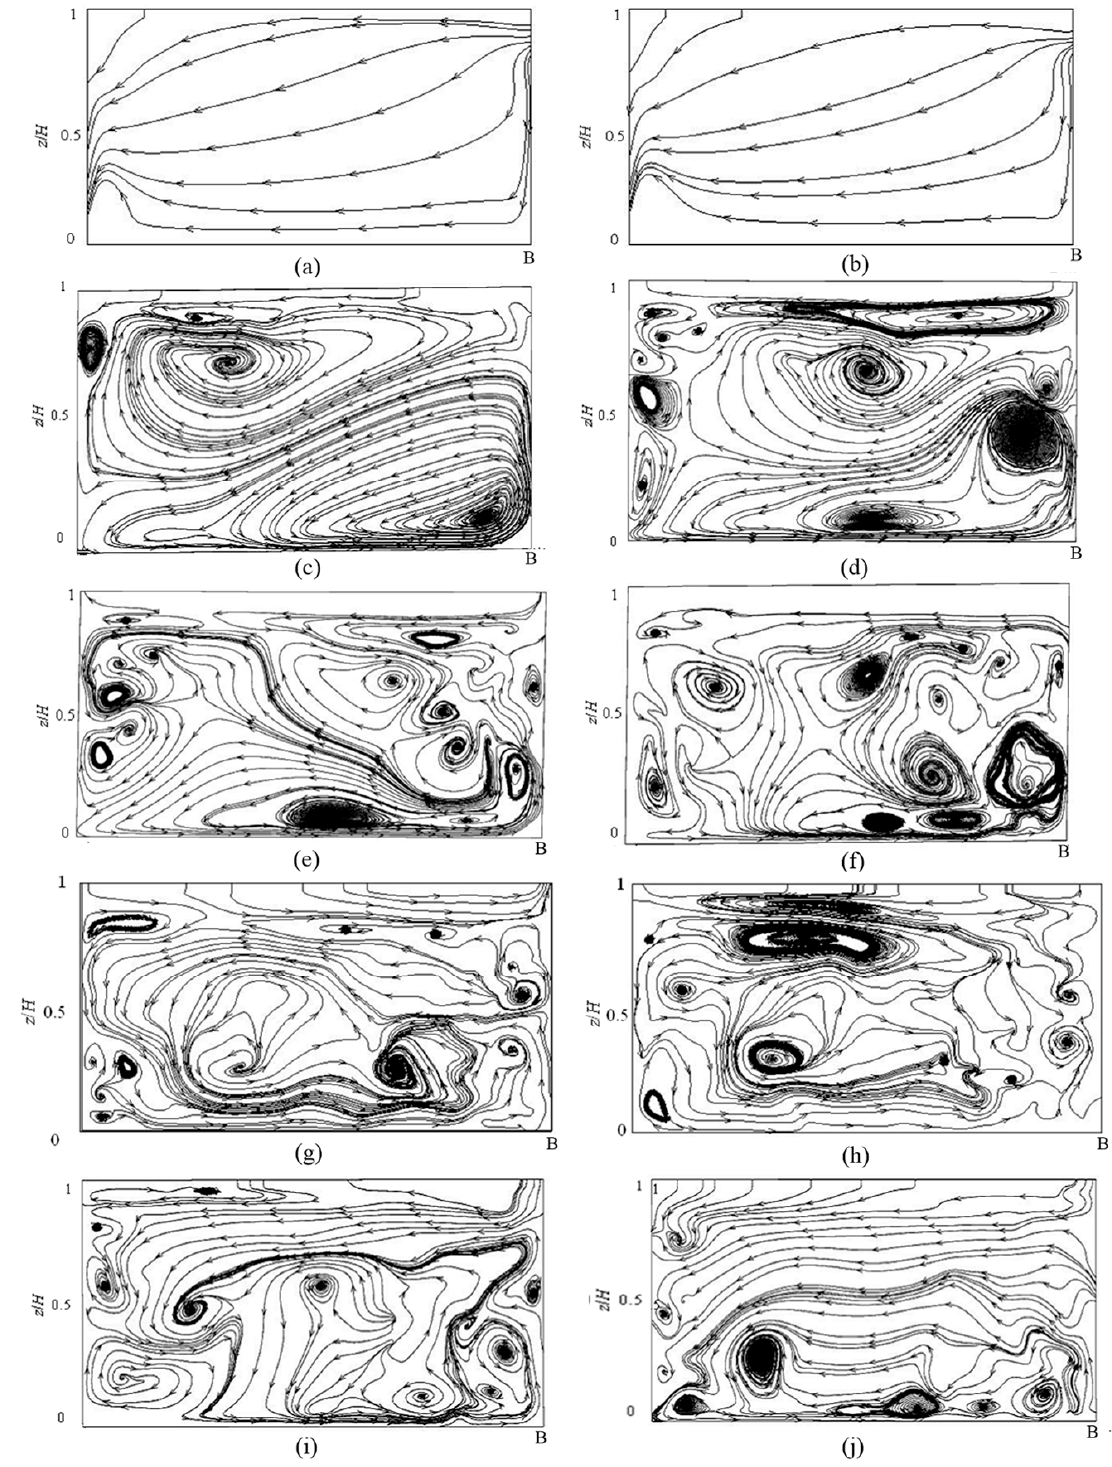
Figure 12. Flow chart of sections: ( a ) Q0.5; ( b ) Q0.8; ( c ) D30; ( d ) D45; ( e ) D60; ( f ) D90; ( g ) D135; ( h ) D180; ( i ) H0.5; ( j ) H0.8.